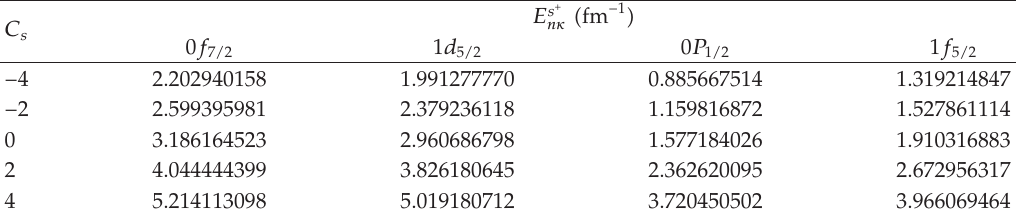
Table 5: Energies in the spin symmetry limit for A (cid:9) 0 . 5, B (cid:9) 0 . 2, b (cid:9) 1, M (cid:9) 1fm − 1 .